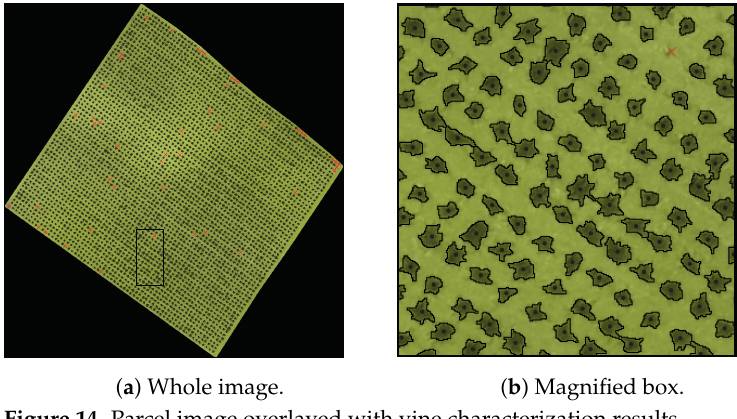
Figure 14. Parcel image overlayed with vine characterization